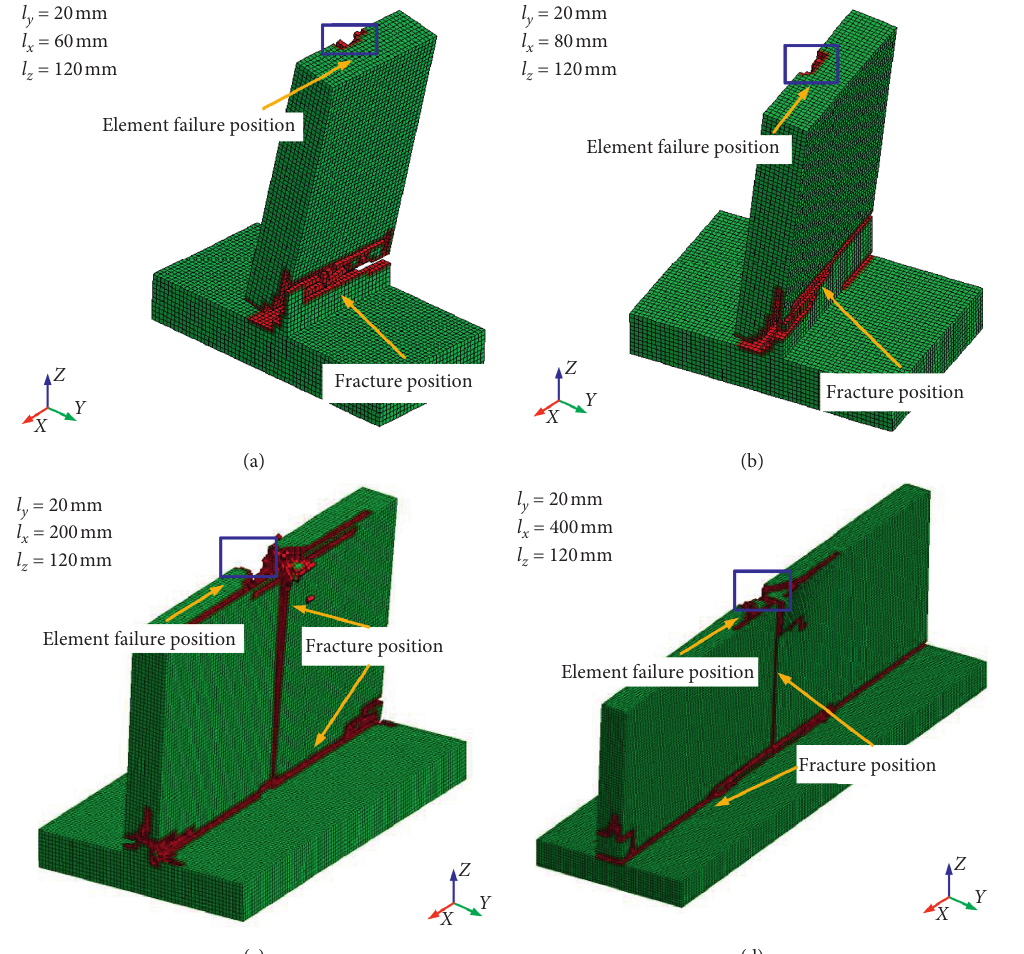
Figure 8: The rock plate cutting results with different widths: (a) 60mm, (b) 80 mm, (c) 200mm, and (d) 400mm.